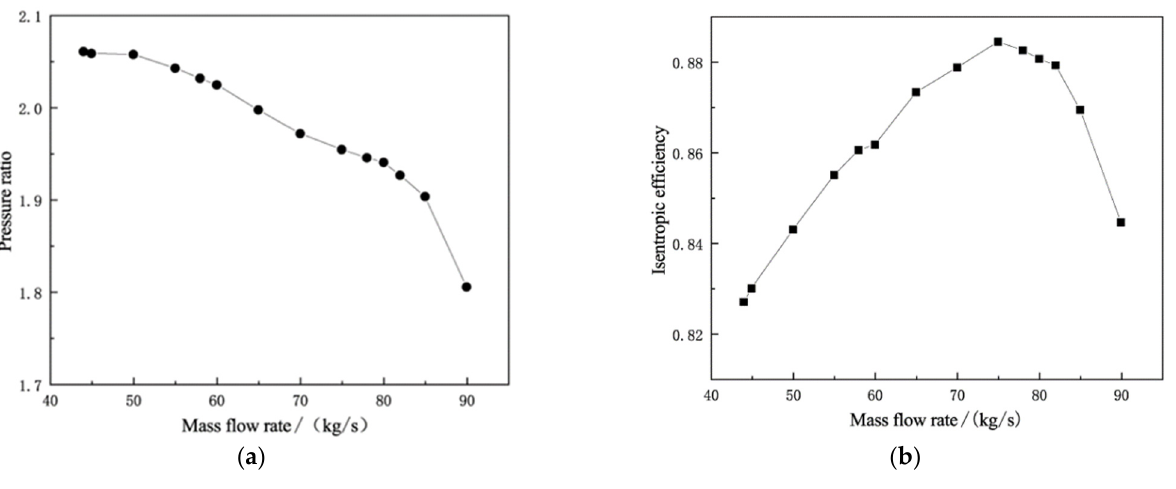
Figure 6. Performance curve at nominal inlet condition. ( a ) Pressure ratio; ( b ) isotropic efficiency.